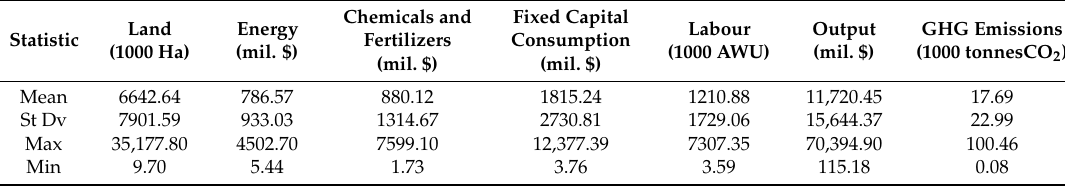
Table 1. Descriptive statistics of DEA inputs and